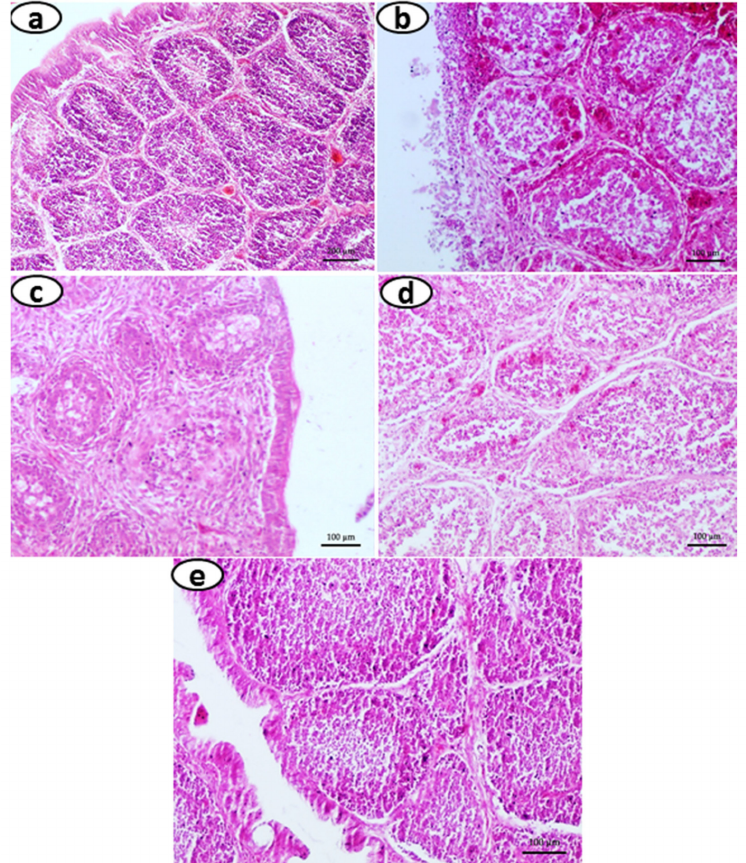
Figure 5. Section of bursa of Fabricius showing ( a ) Normal histo-architecture characterized by bursal follicles with intact cortex and medulla, along with lining epithelium; ( b ) Bursal follicles with severe lymphoid depletion in the cortex and medulla, severe congestion, and hemorrhages are evident. Loss of plical lining epithelium is seen; ( c ) moderate to severe lymphoid depletion in the bursal follicles, along with normal lining of plical epithelium and peri-follicular fibrosis is evident; ( d ) moderate lymphoid depletion in the bursal follicles along with mild peri-follicular fibrosis; ( e ) apparently normal histo-architecture, characterized by bursal follicles with intact cortexes and mild lymphoid depletion in the medulla, along with intact lining epithelium (H&E